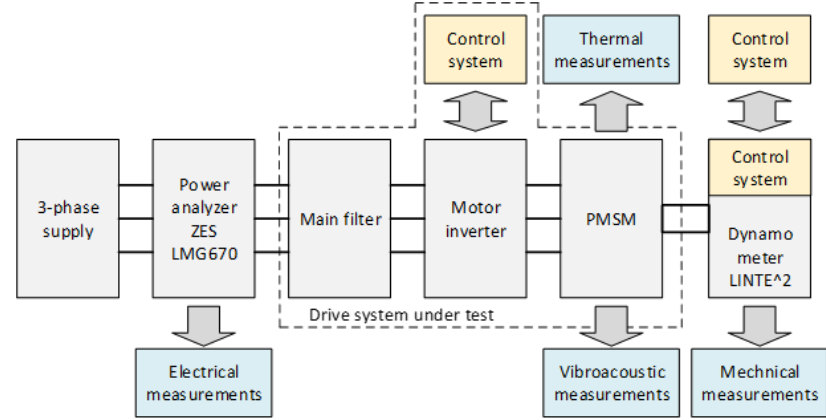
Figure 11. The simplified structure of the measurement system.